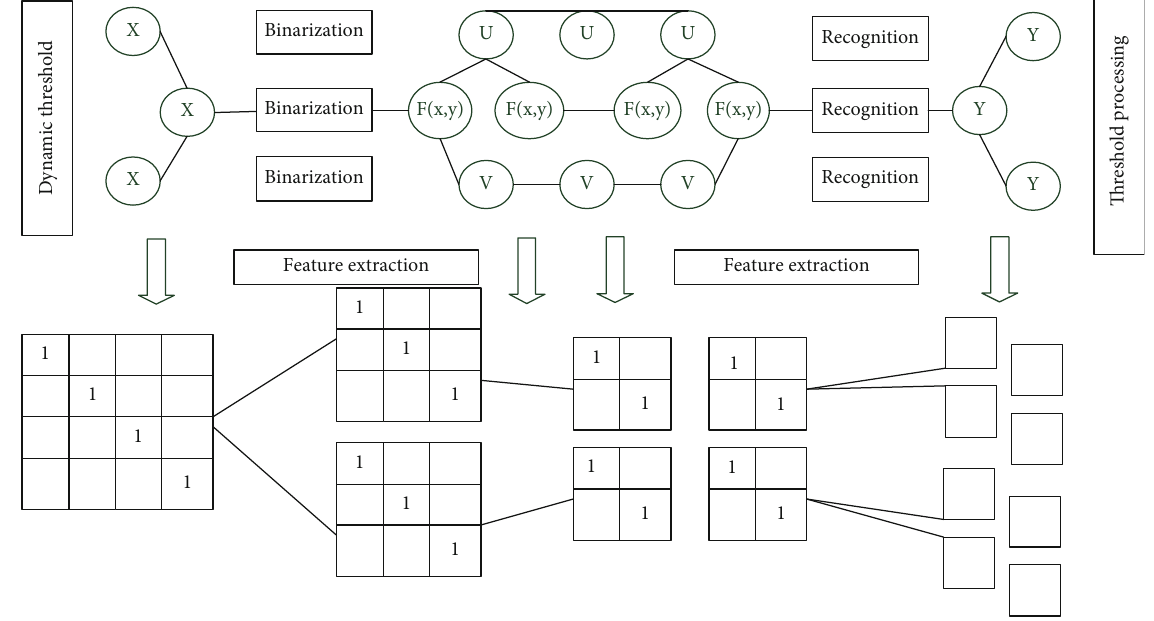
Figure 2: Image recognition algorithm framework